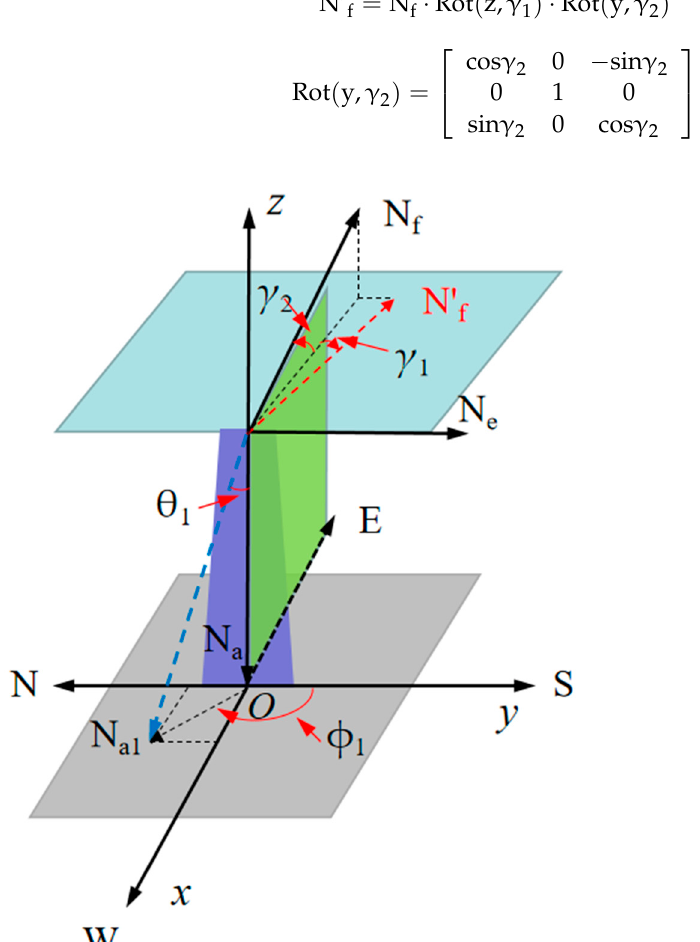
Figure 6. Schematic diagram of initial tracking position of an SDC system. Simplify Equation (19) to get N’ f = [ − cos γ 1 cos γ 2 , − sin γ 1 , cos γ 1 sin γ 2 ]. According to the results, different initial tracking position offsets have the same trend on the effective tracking factor of an SDC system, only with a numerical value difference. In order to display the data more clearly, this section only lists the variation rules of the initial tracking position offset of 0.2° and 0.4°. Figure 7 shows the variation of the effective tracking factor of an SDC system with different initial tracking positions under the azimuth axis tilt error. It can be clearly seen that whether the initial tracking position varies in the horizontal plane or the vertical plane, the larger the deviation angle of the initial tracking position (i.e., the larger γ 1 or γ 2 ), the worse the tracking performance of the SDC system. Regarding the symmetric initial tracking position offset angle in the due east direction (i.e., γ 1 = 0.2° and γ 1 = − 0.2°), the tracking performance change trends are exactly opposite. From Figure 7a, it can be seen that when γ 1 > 0°, the azimuth axis tilt error has the least influence on the tracking performance at the azimuth axis tangential angle ϕ 1 = 345° (i.e., 15° south by east) or ϕ 1 = 165° (i.e., 15° north by west). In the azimuth axis tangential angle ϕ 1 = 0° (due south) or ϕ 1 = 180° (due north), the azimuth axis tilt error has the most influence on tracking performance. Similarly, it can be seen in Figure 7b that when γ 2 > 0°, the azimuth axis tilt error affects the tracking performance the least at the azimuth axis tangential angle ϕ 1 = 75° (i.e., 75° south by west) or ϕ 1 = 225° (i.e., 75° north by east). In the azimuth axis tangential angle ϕ 1 = 345° (i.e., 15° south by east) or ϕ 1 = 165° (i.e., 15° north by west), the azimuth axis tilt error affects the tracking performance the most.